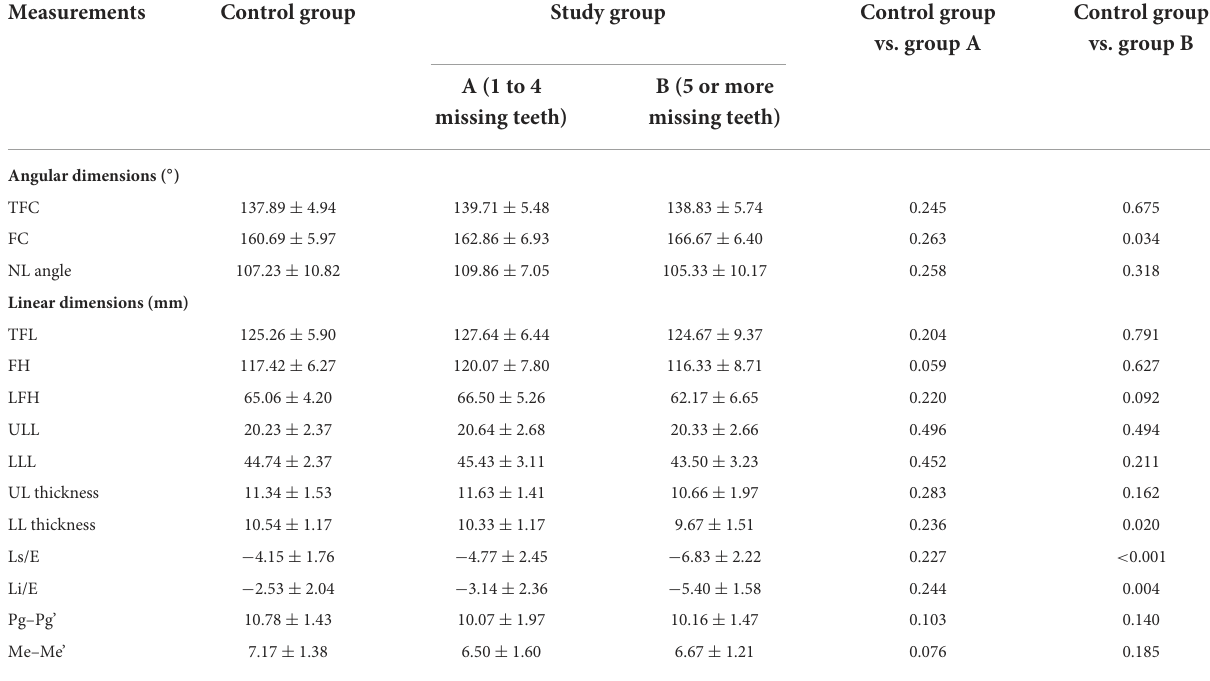
TABLE 7 Comparison of the soft tissue cephalometric means and standard deviation (SD) between the control and study groups. Measurements Control group Study group Control group